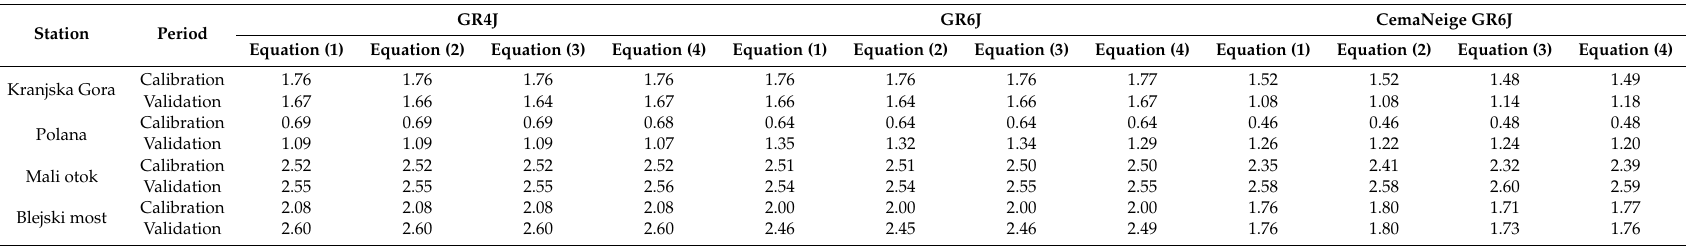
Table 2. Root Mean Square Error (RMSE) criteria values for discharge results (mm) in case of four investigated catchments for the calibration and validation periods using di ff erent input values for the mean air temperature